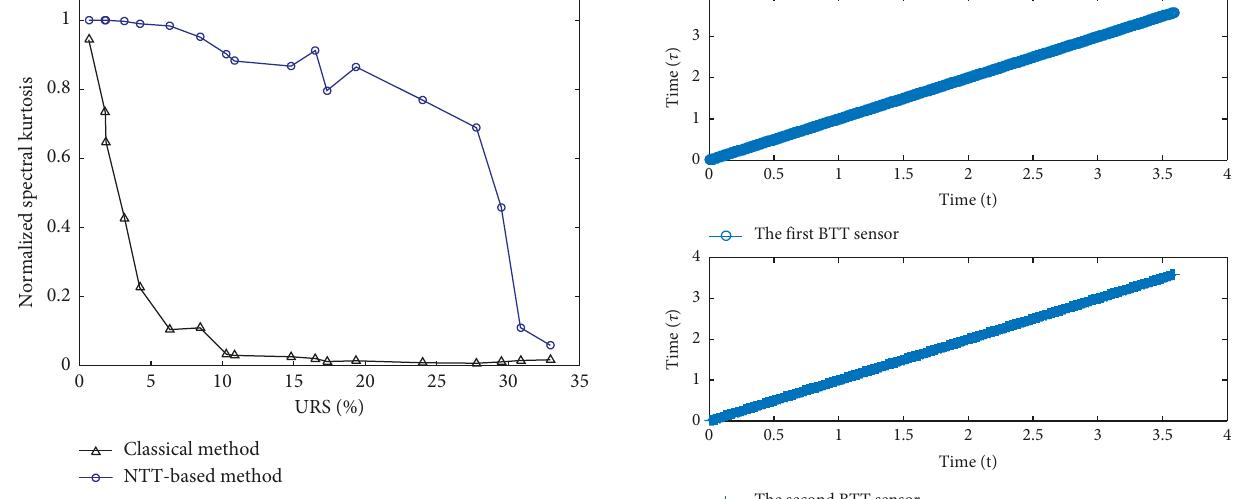
Figure 8: Normalized spectral kurtosis of uniformly reconstructed signals under different URS.